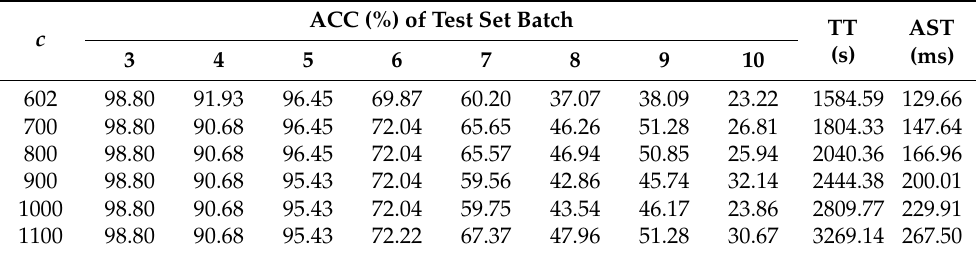
Table 6. Experimental results and average time for dataset2.